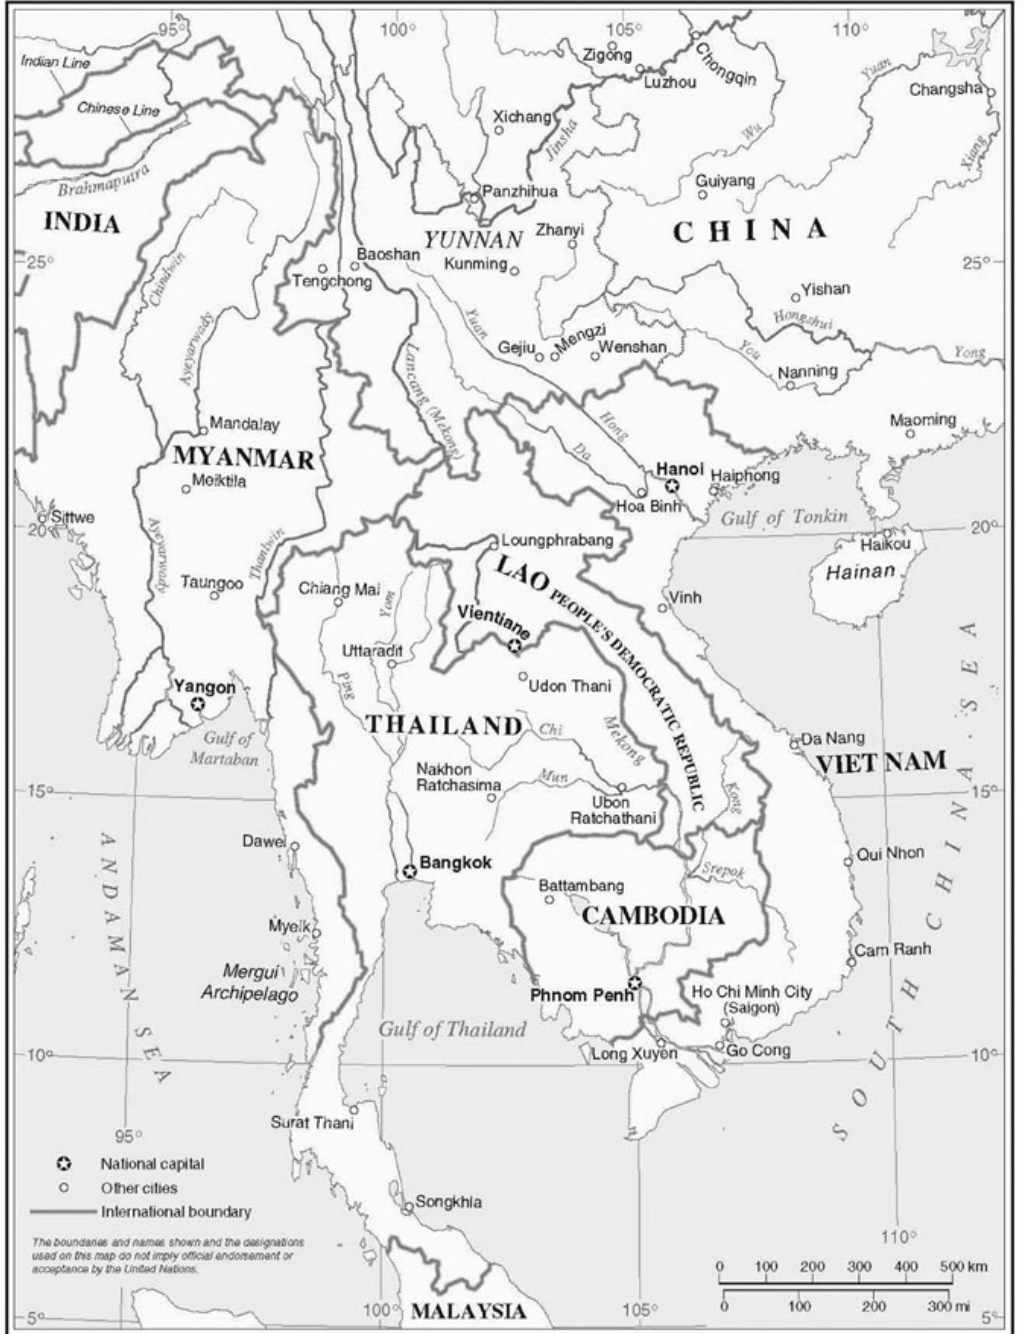
Fig. 2. The main rivers and national boundaries of the Mekong